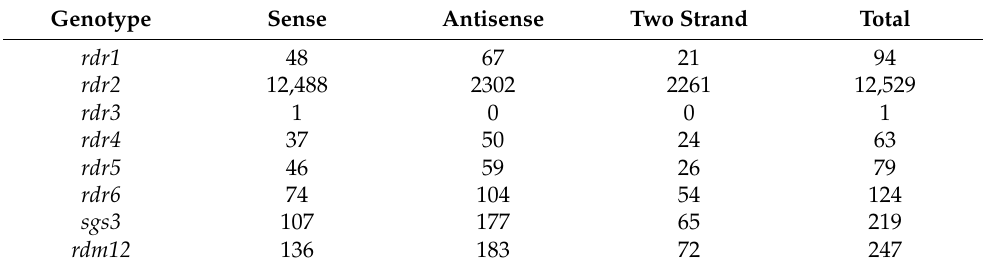
Table 1. Summary of putative substrates for the six RDRs and two cofactors identified in TAIR10 annotated transcripts. Two strand indicates putative substrates appeared on both the sense and antisense strands, and total means the total number of putative substrates identified. For annotated transcripts, strand information is given. The population of putative RDR substrates that was signifi- cantly downregulated in the mutants when compared with Col-0 are shown (smRNA counts down by 1/3, FDR <